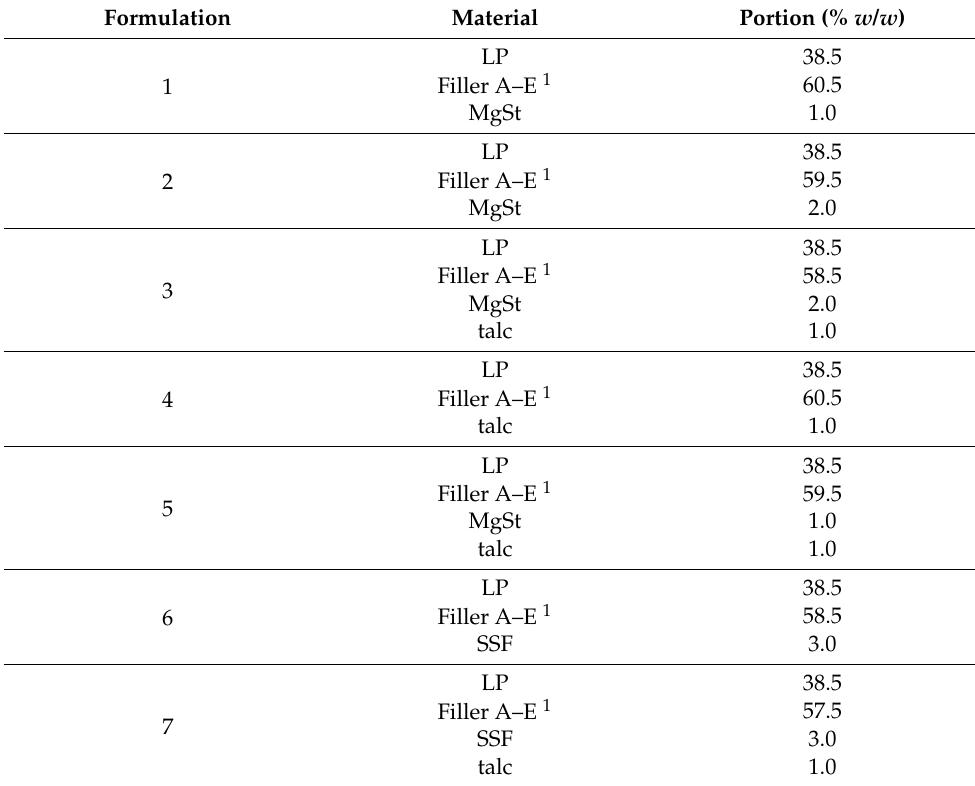
Table 1. Overview of the main formulations of development step I. LP = losartan potassium; MgSt = magnesium stearate; SSF = sodium